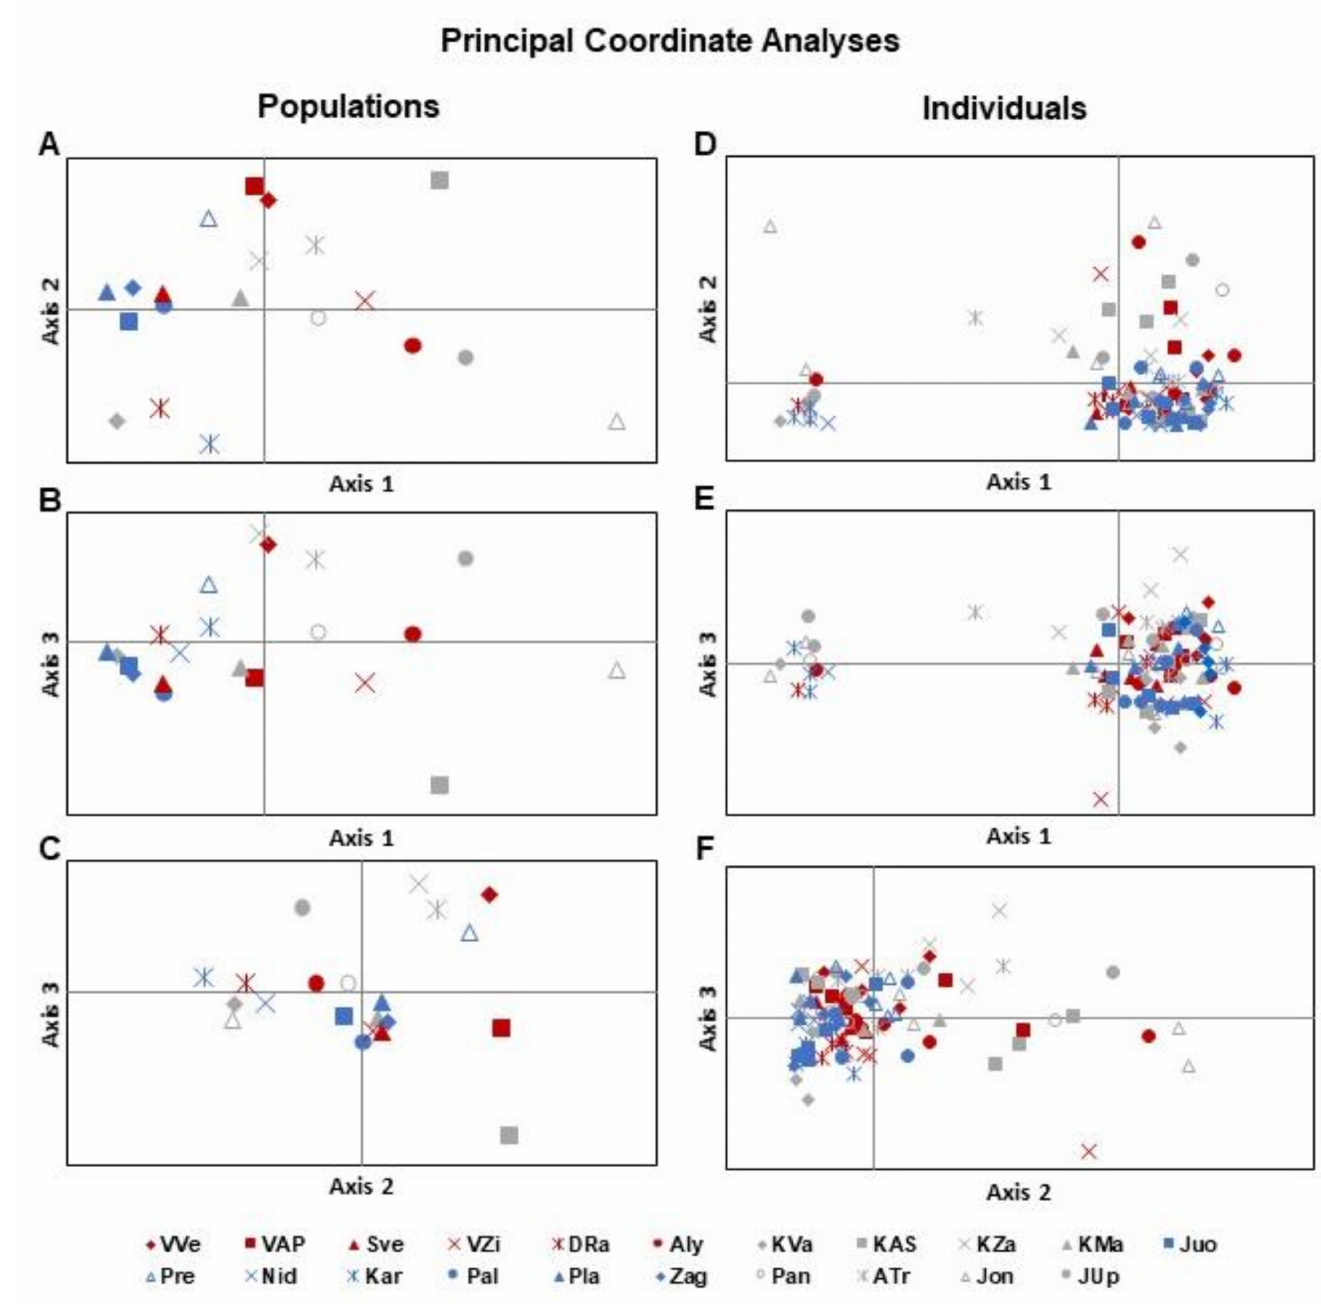
Figure 3. Two dimensional PCoA plots of small balsam ( I. parviflora ) populations ( A – C ) and individ- uals ( D – F ). Different colors of the labels indicate geographical location of populations: blue—north- western, gray—central, and red—south-eastern part of Lithuania. The site codes correspond to the data presented in Figure 1. Principal coordinate analysis of AFLP data for individuals showed that coordinate 1 accounted for 8.5%, coordinate 2 for 7.5%, and coordinate 3 for 5.0% of the total varia- tion. The importance of the first two coordinates comprised 16.0% and importance of the first three coordinates comprised 20.9% of the total genetic variance of I. parviflora individuals (Figure